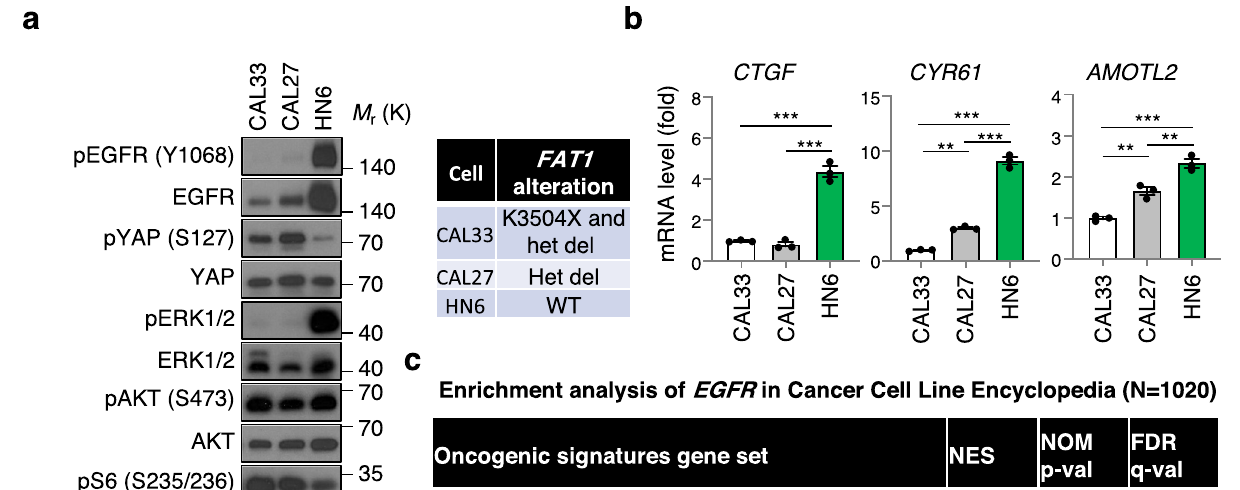
expressing HEK293A cells showed almost no effect on YAP by EGF treatment, but EGFR-overexpressing HEK293A showed signi fi cant pYAP reduction concomitant with CTGF , CYR61 , and AMOTL2 mRNA increase, as well as ERK1/2, AKT, and S6 phosphorylation (Fig. 2a and b). PIK3CA WT and H1047R overexpression slightly increased YAP/TAZ and